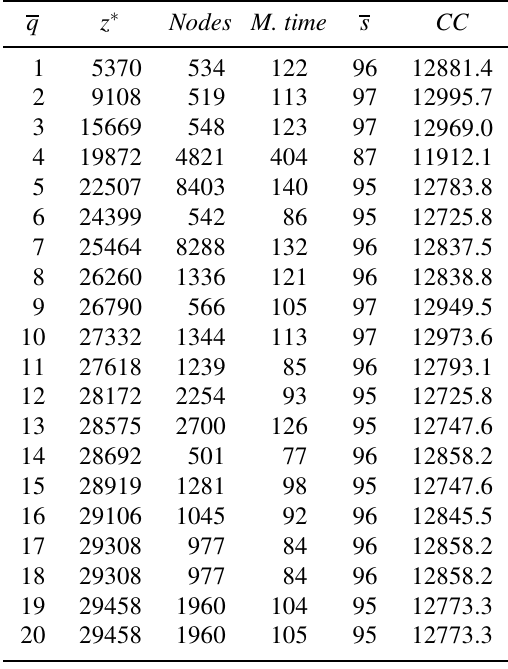
Table 6. Computational results for C 3